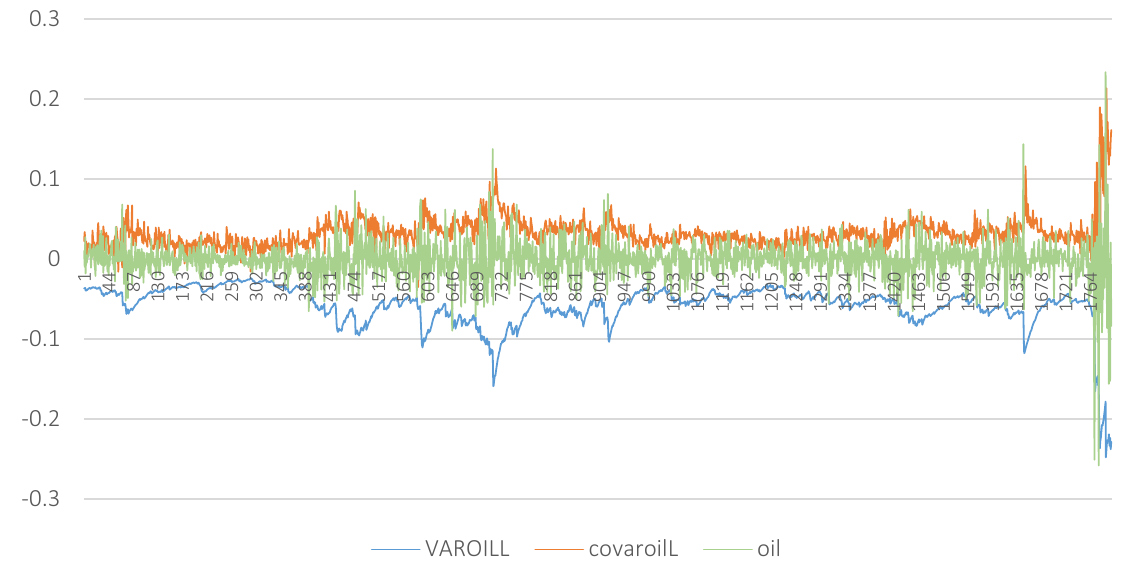
Figure 2. Rolling VaR values and returns of crude oil